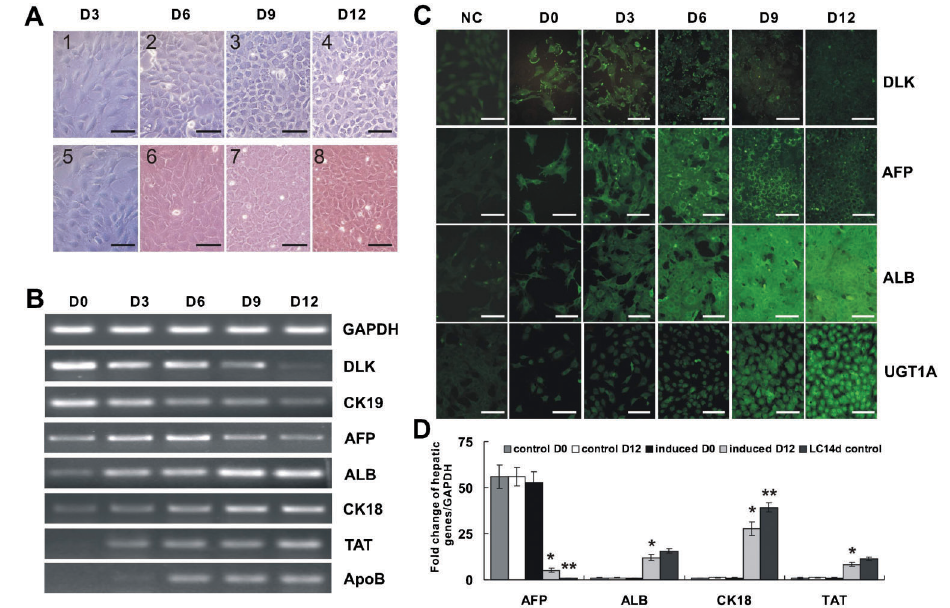
Figure 3. Expression of liver cell markers during the induced maturation of hepatic progenitor cells (HPCs). Cells were treated with the combination condition of 2% HS++0.1 m M Dex++10 ng/mL HGF++20 ng/mL FGF4. A , The morphology of untreated and treated cells at D3, D6, D9, and D12 days after induction. Panels 1, 2, 3, and 4 are untreated cells; 7, 8, 9, and 10 are induced cells. Scale bar=200 m m. B , RT-PCR analysis of hepatic-related genes DLK, CK19, AFP, ALB, CK18, TAT, and ApoB at D0, D3, D6, D9, and D12 after induction. RT-PCR results were confirmed in at least three independent experiments, and representative results are shown. C , Immunofluorescence staining of DLK, AFP, ALB, and UGT1A markers at D0, D3, D6, D9, and D12 days after induction. Negative controls (NC) are cells stained with nonspecific IgG. Scale bar=200 m m. D , Real-time PCR analysis of hepatic related genes AFP, ALB, CK18, TAT of the induced cells at D12 compared with untreated cells as negative controls and adult liver cells as positive